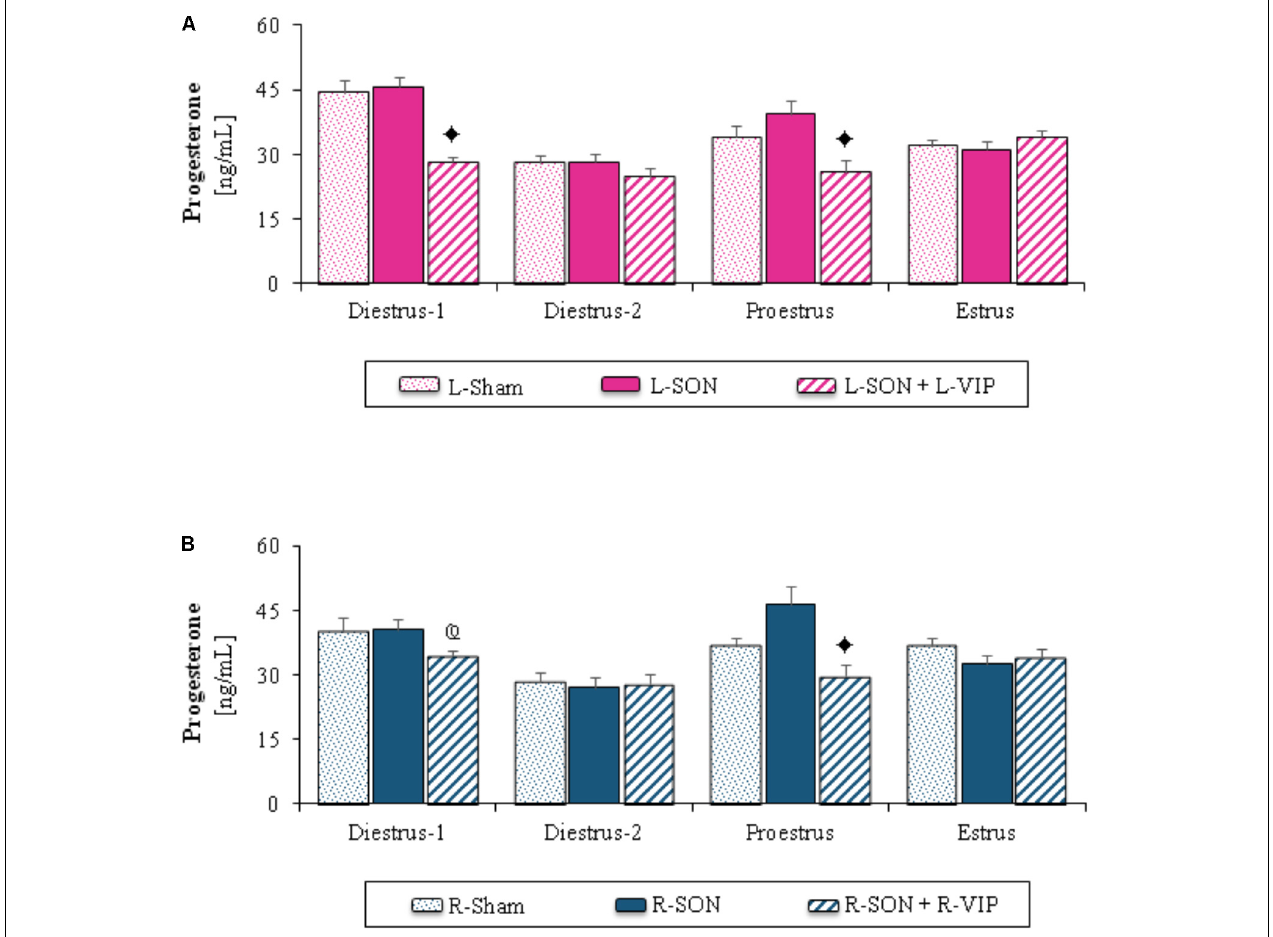
FIGURE 1 | Mean ± SEM of progesterone (ng/mL) serum levels in animals submitted to left (A) or right (B) sham surgery (L-Sham or R-Sham), or the left or right sectioning of the superior ovarian nerve (L-SON or R-SON) with or without subsequent treatment with VIP into the left or right denervated ovary (L-VIP or R-VIP). Animals were sacrificed 1 h after surgery. (cid:70) p < 0.05 vs. its respective L-SON or R-SON group; p < 0.05 vs . group with the same treatment of the left side (Student’s t